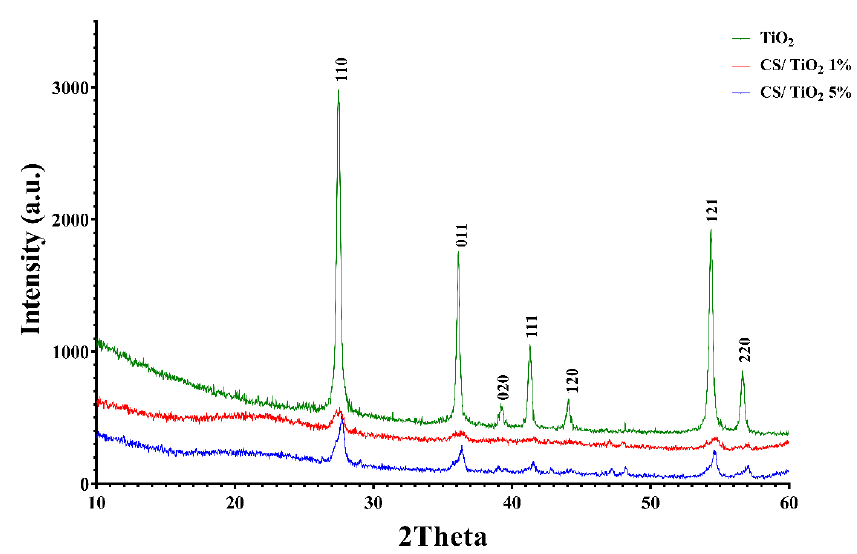
Figure 4. XRD analysis of TiO 2 and chitosan/TiO 2 composite membranes.